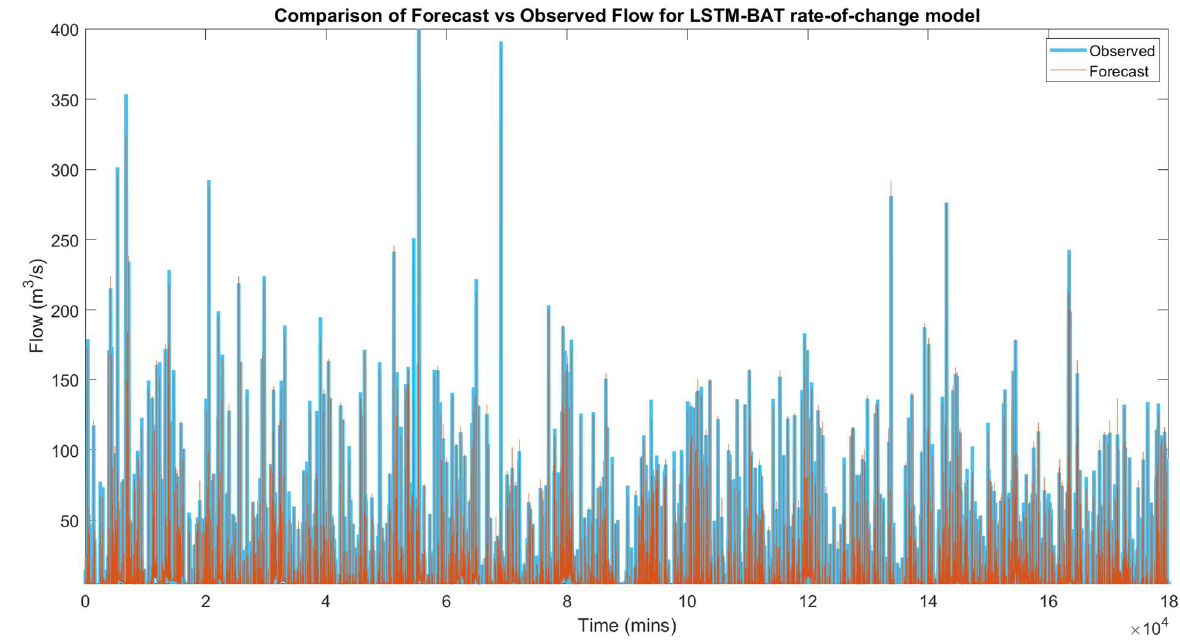
Bat algorithm: observed vs. forecast flow—rates of change model Figure 9. Graphs of optimization-LSTM hybrid models. Figure 9. Graphs of optimization-LSTM hybrid